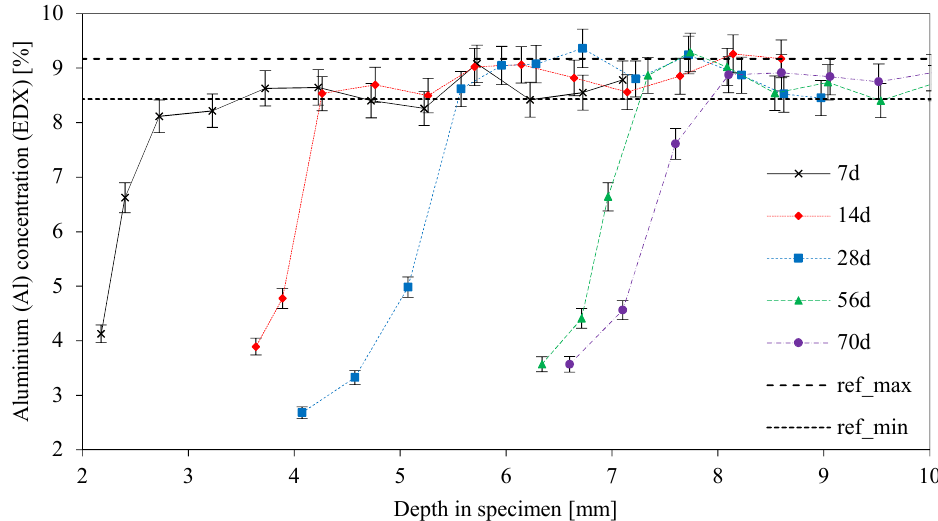
Figure 14. Aluminum concentration from EDX elemental mapping, as a function of depth in the specimen. Curves for di ff erent exposure times up to 70 days and reference lines ref min and ref max from the original unexposed geopolymer sample.